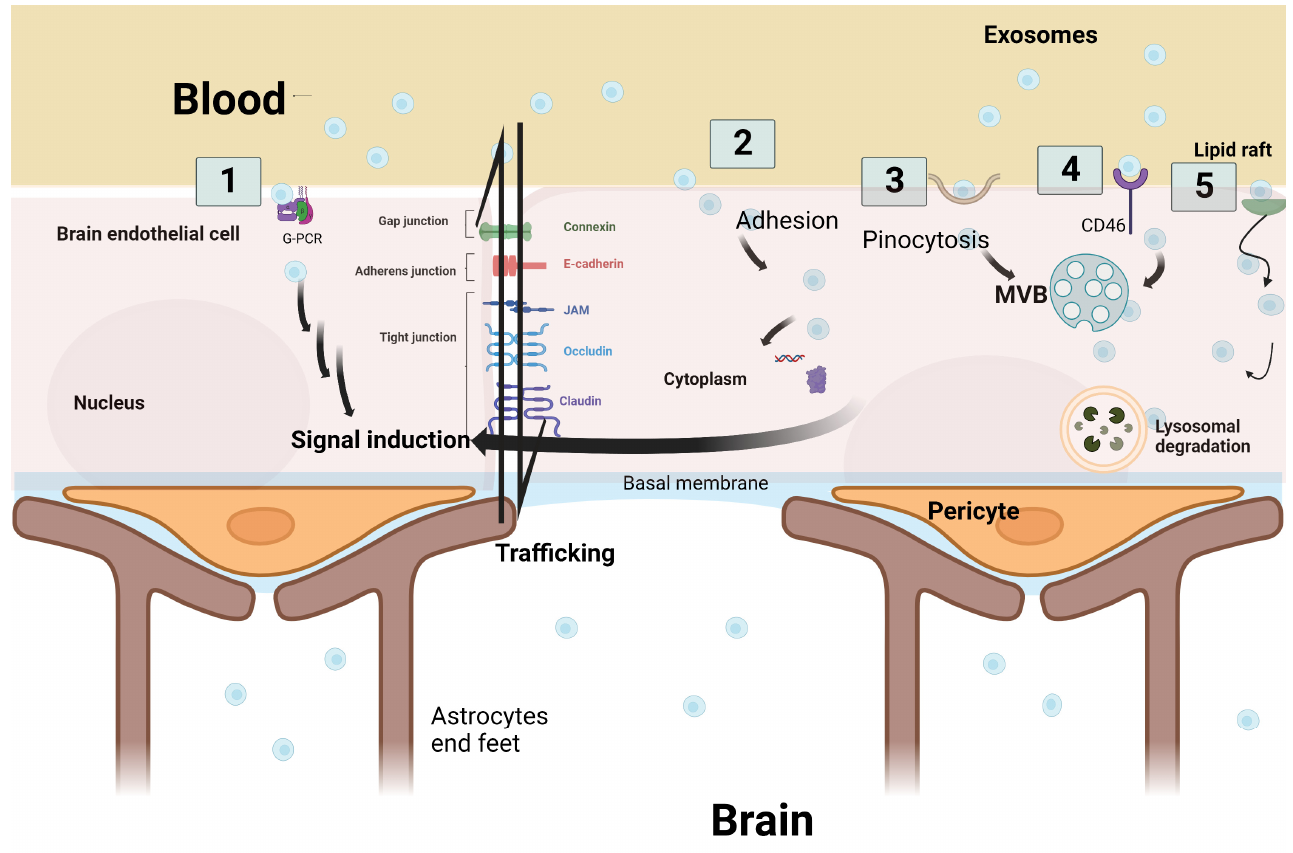
Figure 3. Schematic representation of the five hypothetical routes of exosome transcytosis through the brain endothelium at blood–brain barrier. (1) Exosomes from the blood bind to G-protein coupled receptor (GPCR) at the brain endothelium and induce downstream signaling cascade pathways. (2) Adhesion of exosomes and fusion through the endothelial cell membrane is followed by the secretion of exosome cargo into the cytoplasm to induce signal cascades. (3) Exosomes are incorporated into the cells by inverse membrane invagination. (4) Exosomes from the blood bind to receptors such as CD46, which leads to exosome entry into the cell. (5) Non-specific lipid raft that binds to exosomes and aids in their incorporation. Three outcomes are expected after transcytosis: signal induction, lysosomal degradation, or trafficking through brain endothelial cells. Original Photo created with BioRender.com.